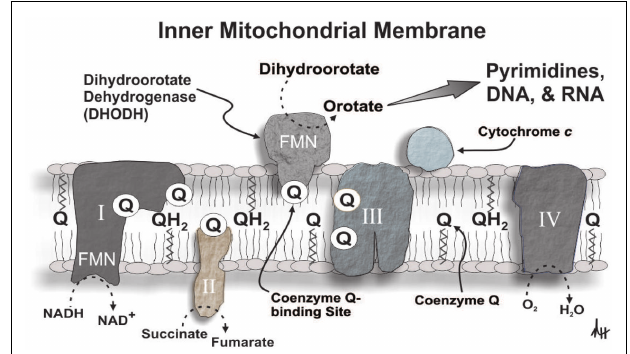
FIGURE 2 |A diagrammatic depiction of DHODH in the inner mitochondrial membrane illustrating its role in mitochondrial bioenergetics and de novo pyrimidine synthesis. Please refer to the text for additional details (abbreviations: I, complex I; II, complex II; III, complex III; IV, complex IV; FMN, flavin